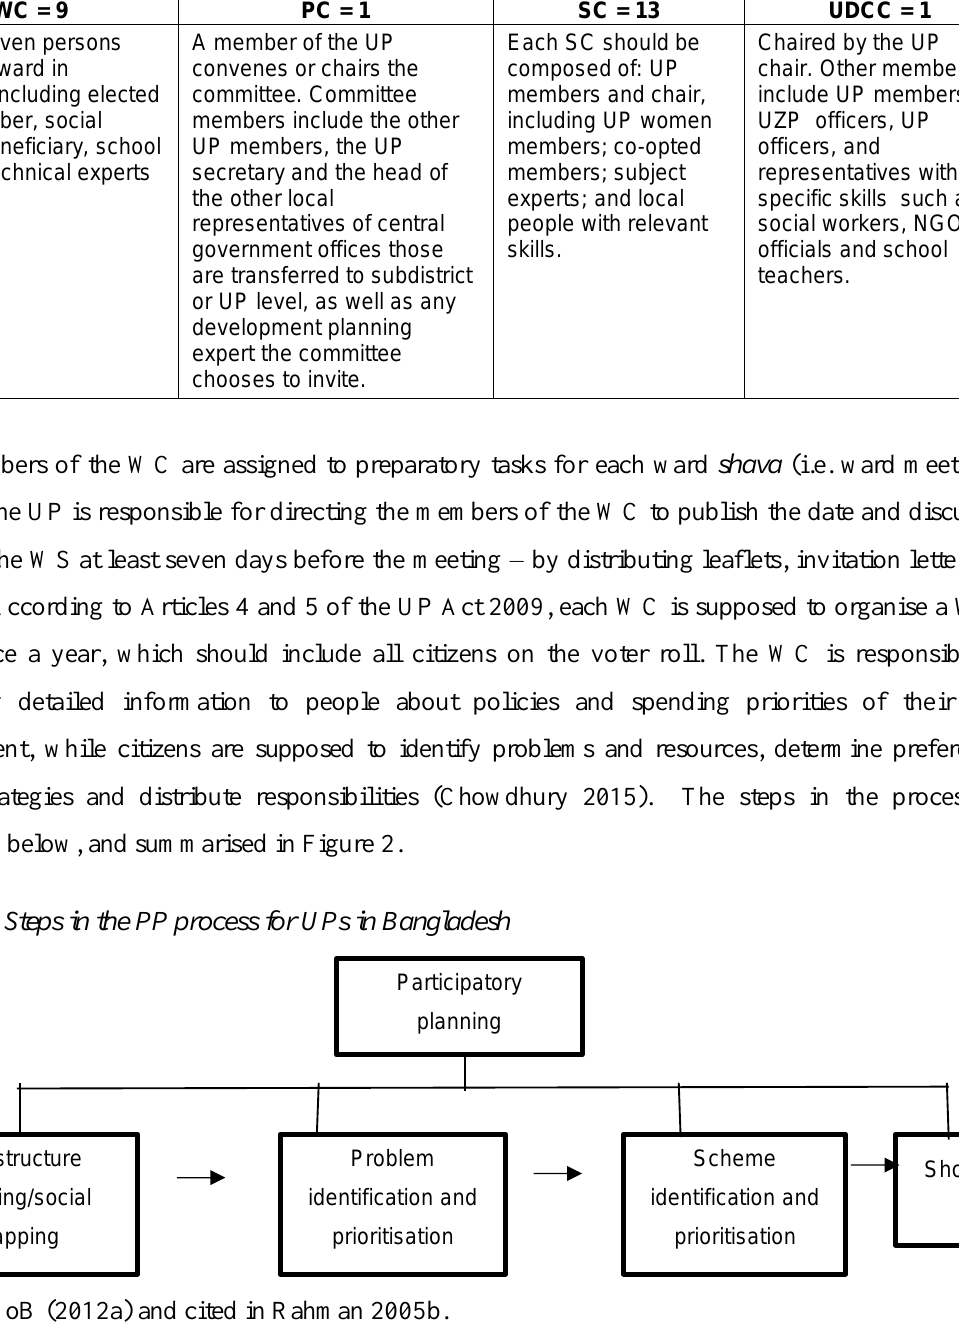
Table 1: Committee structure for UP planning and budgeting WC = 9 UDCC = 1